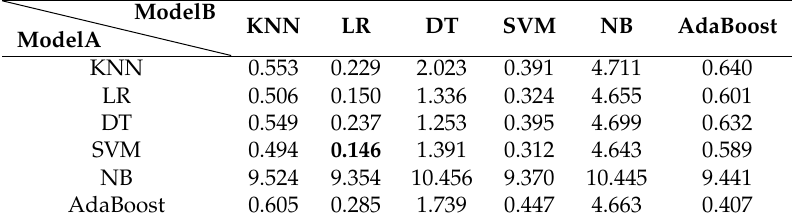
Table 8. The FPR (%) achieved by different combinations of Model A and Model B.